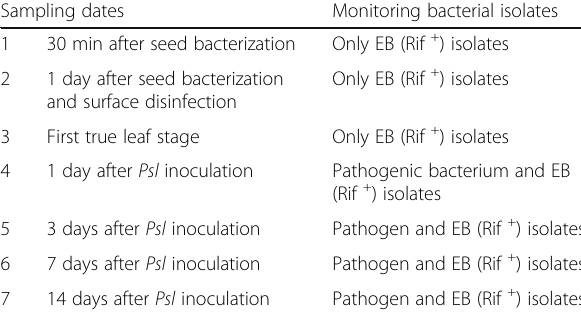
Table 2 Time intervals to monitor population dynamics and colonization of endophytic bacteria (Rif + ) isolates and pathogen inside cucumber root and